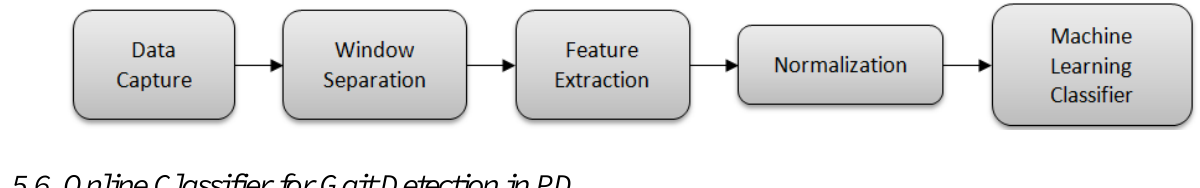
Figure 7. Classical classification